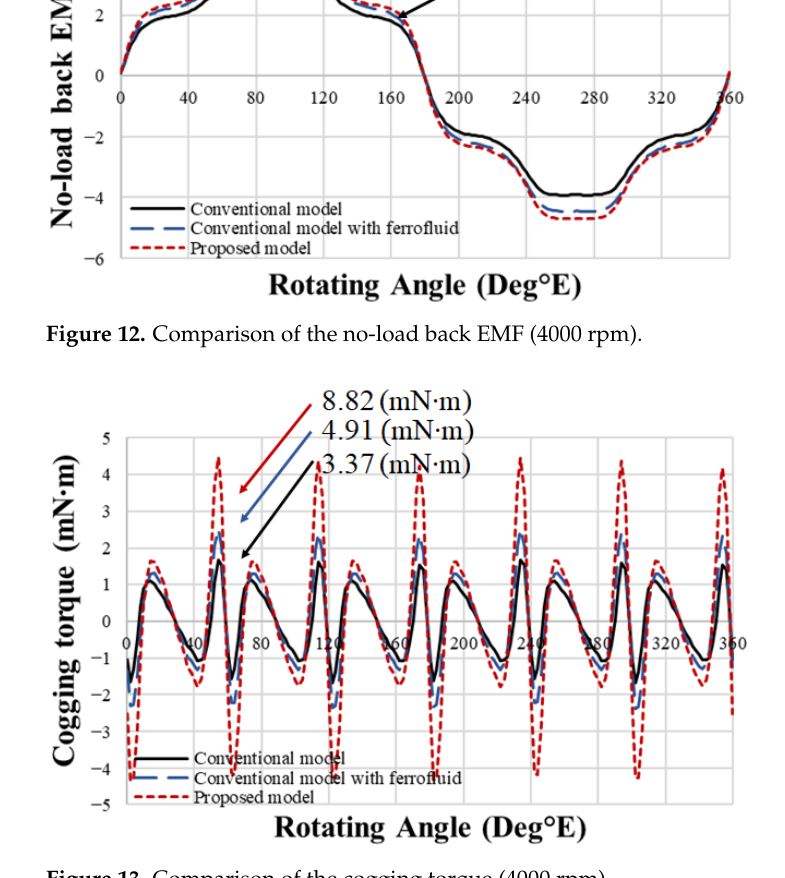
Figure 13. Comparison of the cogging torque (4000 rpm). Table 2. Target